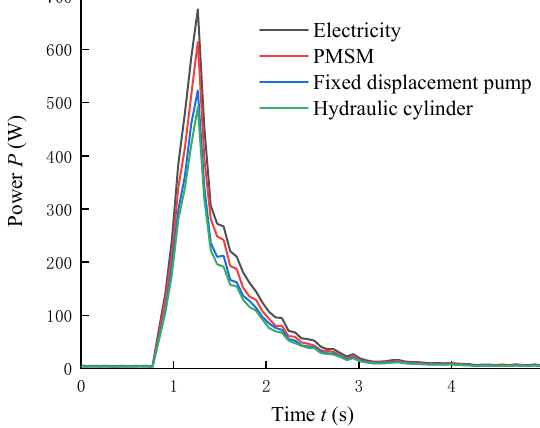
Figure 9. Experimental power curve of key components.